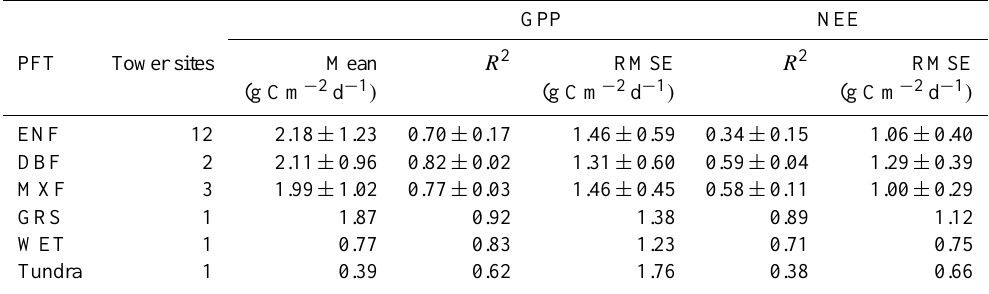
Table 2. Coefficient of determination ( R 2 ) and root mean square error (RMSE) differences between model-simulated daily carbon fluxes and in situ tower EC measurement-based observations across the study area. The mean of tower-observed daily GPP flux is also shown. The uncertainty of the estimates including mean, R 2 and RMSE values was indicated as a standard deviation when there were multiple sites represented for each plant functional